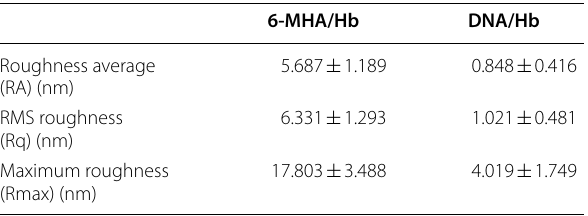
Table 1 Analysis of surface